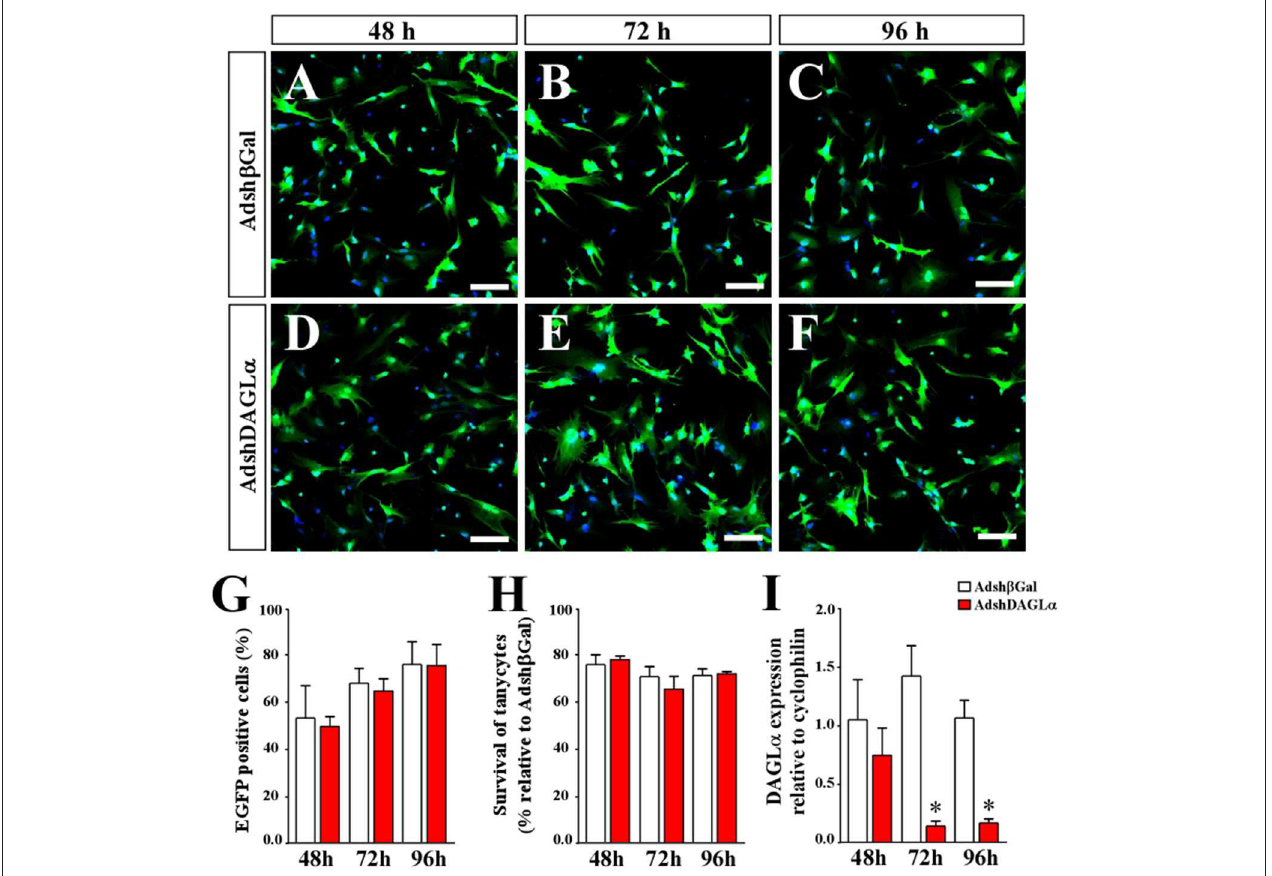
FIGURE 3 | Evaluation of adenoviral particles carrying DAGL α -specific shRNAi. (A–F) Representative images for in vitro cultures of tanycytes infected with AdshDAG α and Adsh β gal as a control adenovirus for 48–96h. (G) Quantification of transduction percentages by the adenoviral particles used in (A–F) . (H) Quantification of cell survival shown as the percentage of transduced tanycytes with AdshDAG α and Adsh β gal at 48–96h post-transduction. (I) mRNA levels for DALG α in transduced tanycytes with AdshDAG α and Adsh β gal at 48–96h post-transduction. N = 4 independent experiments for viability and transduction. Bars represent average ± S.D. Bar size = 20 µ m. * p <